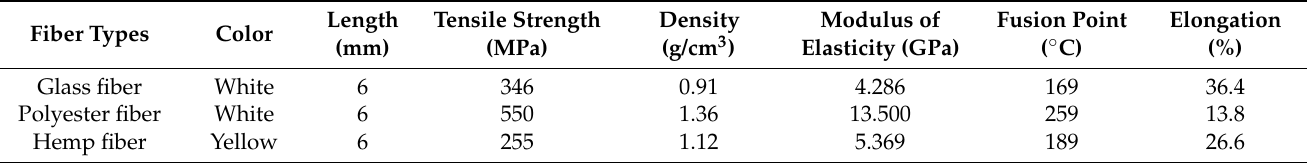
Table 2. Physical and chemical properties of the fibers.